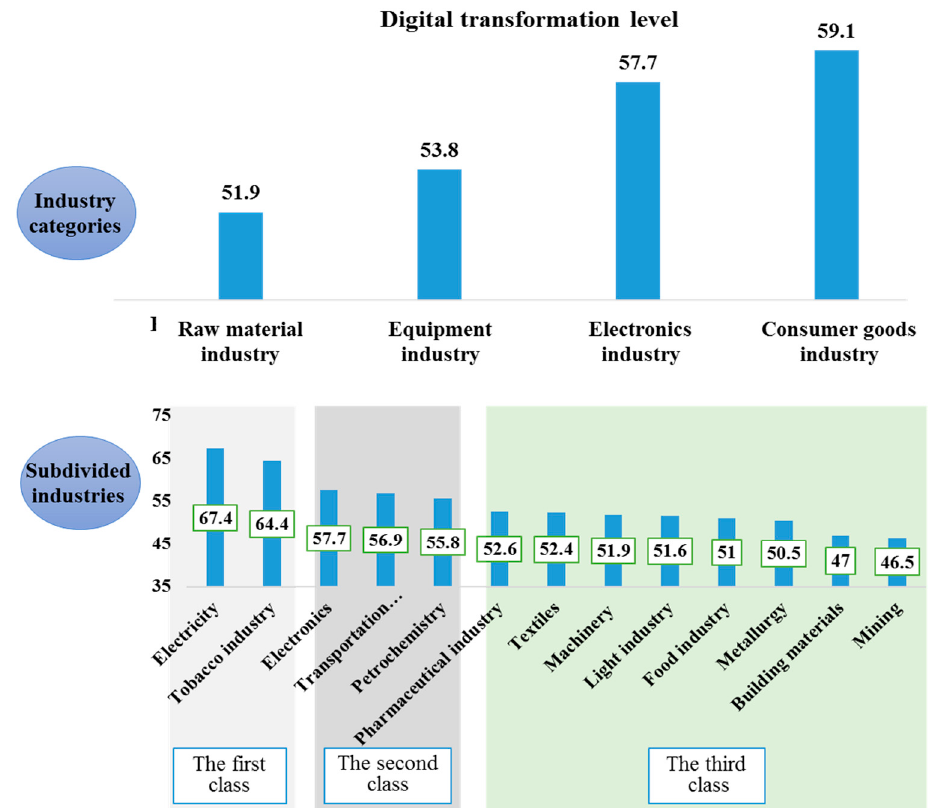
Figure 11. Overview of sectors’ digital transformation in China.